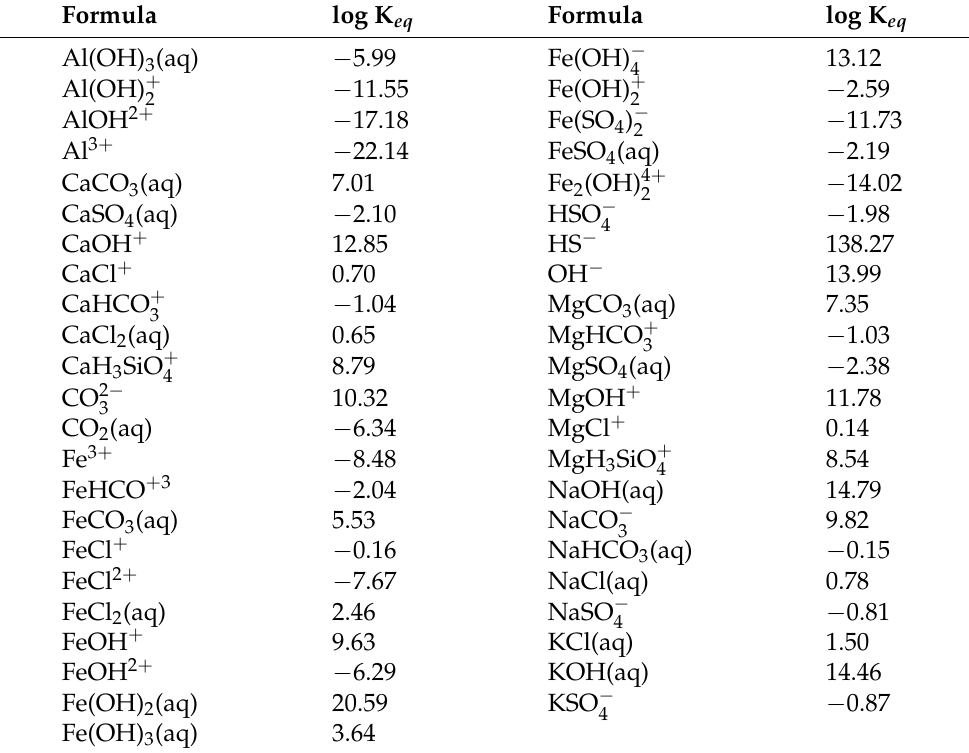
Table 5. Secondary species with their equilibrium constants (log K eq at 25 ◦ C) taken into account in the numerical model. Reactions are written as the dissolution of 1 mol of mineral in terms of the